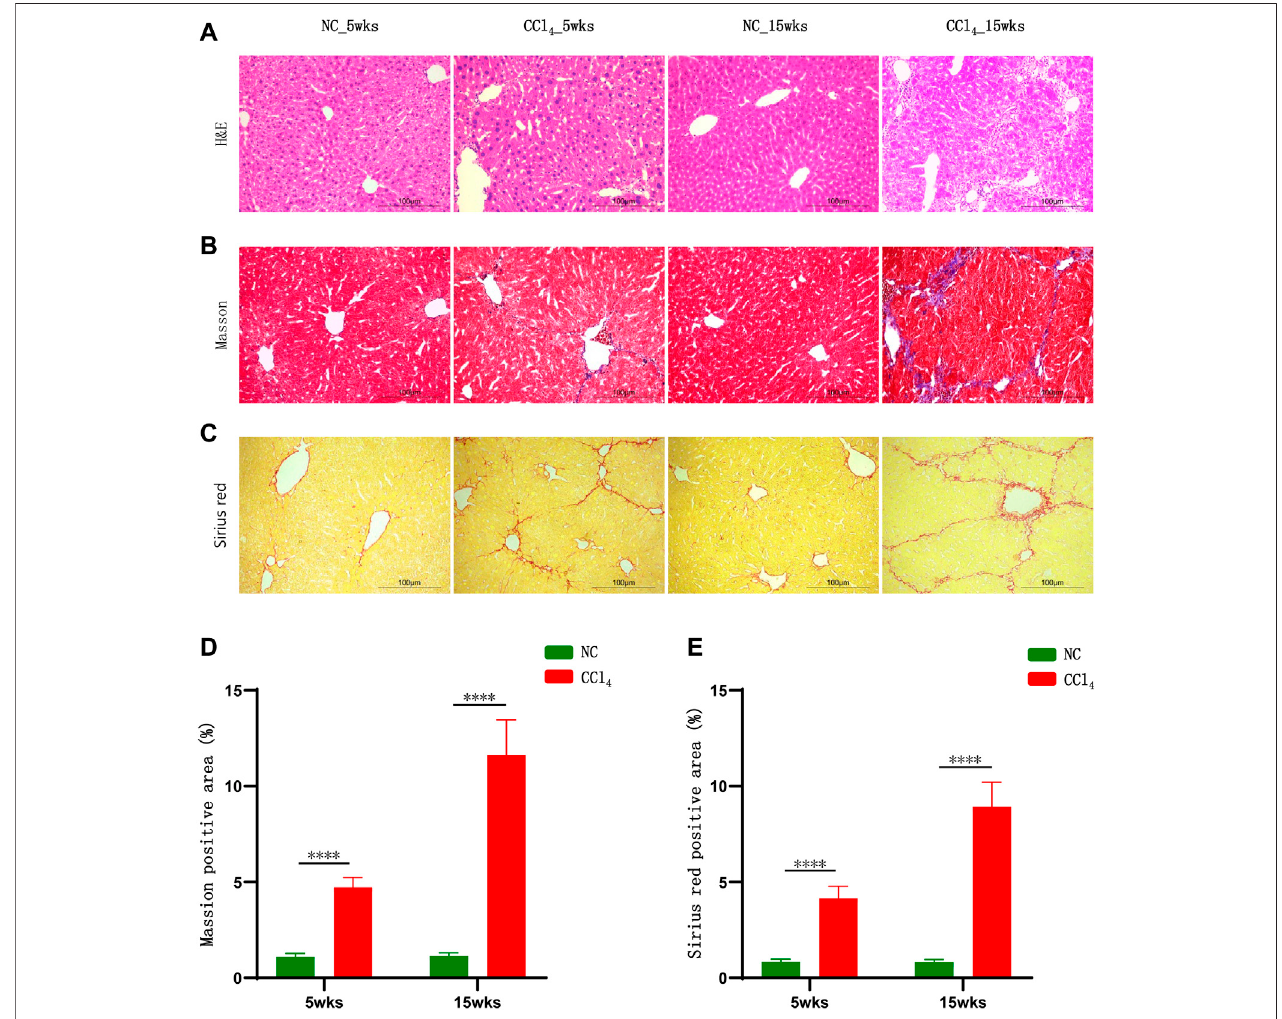
FIGURE 1 | CCl 4 gradually induced liver cirrhosis in mice. (A – C) Representative H&E, Masson ’ s trichrome, and Sirius red staining of liver in mice after 5 and 15 weeks of CCl 4 treatment. (D, E) Morphometric analysis of Masson ’ s trichrome and Sirius red staining; results were presented as the percentage of positive area. Note:Dataweregivenasmean ± SD.n: (D,E) 10pergroup.**** p < 0.0001.Abbreviations:NC,normalcontrol;CCl 4 ,carbontetrachloride;H&E,hematoxylinandeosin; SD, standard